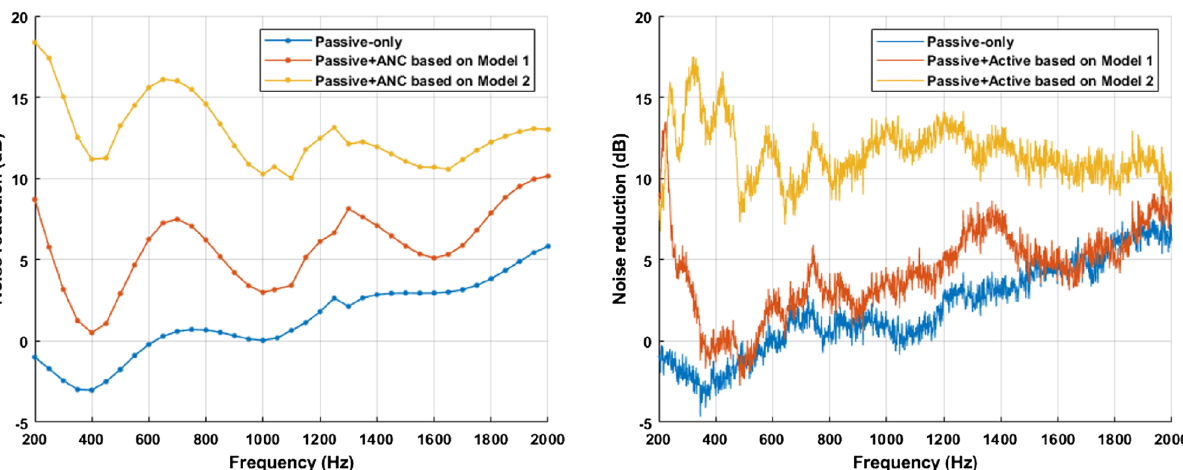
Figure 9. Noise reduction performance in the simulation (left) and in the experiment (right): noise barrier (blue), hybrid noise control using the control filter based on model 1 (red), and hybrid noise control using the control filter based on model 2